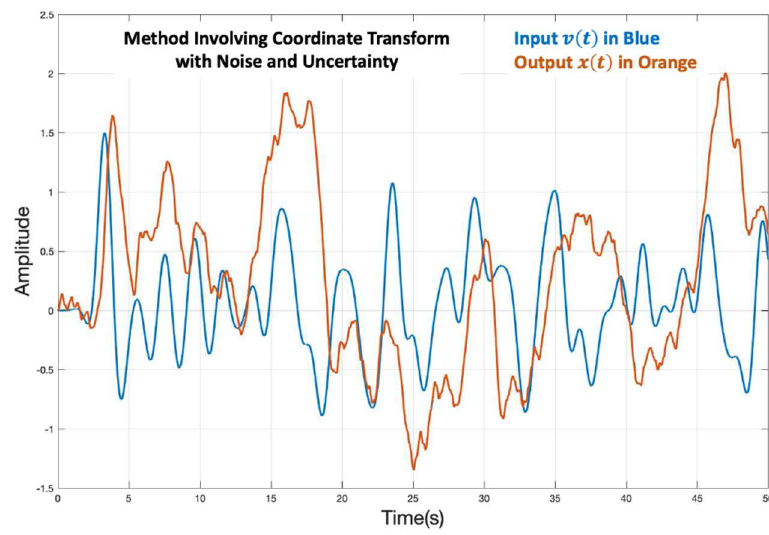
Figure 20. Impact of Noise and Uncertainty (Techniques 2 and 3).